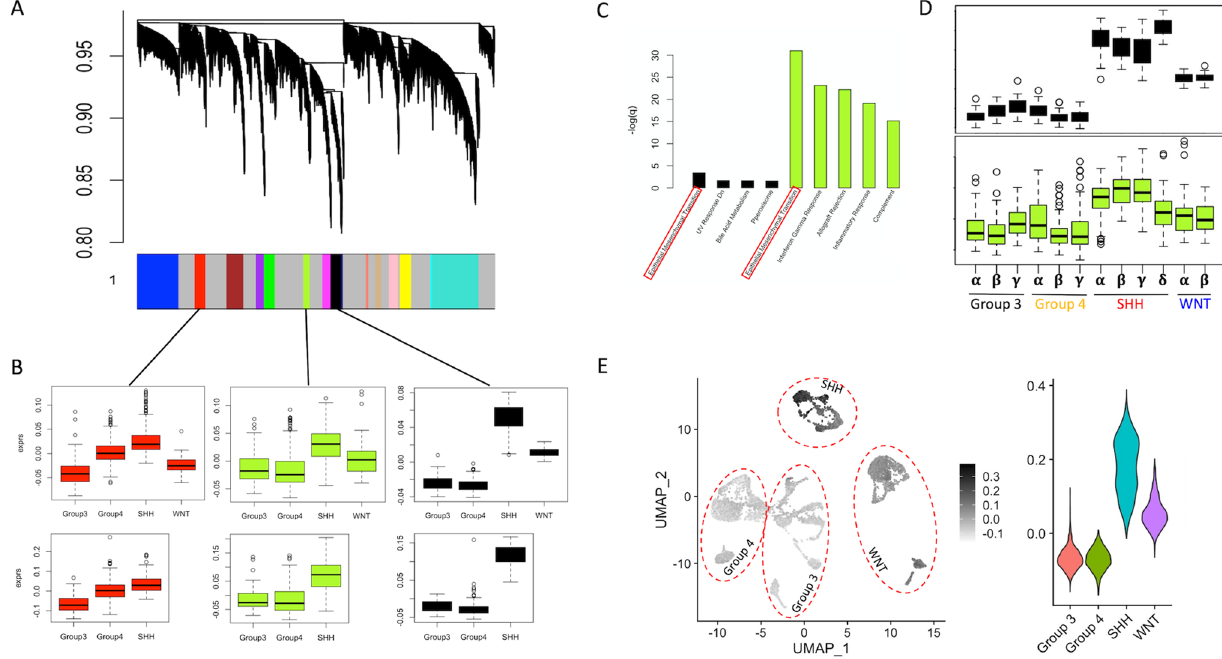
Figure 3. Weighted gene co-expression network analysis (WGCNA) yields SHH-specific TME signatures from the whole transcriptome. ( A ) Dendrogram depicting gene clustering and module selection, where module groupings are annotated by the color bar below. ( B ) Boxplots of the meta-gene expression for each module with highest expression in the SHH subgroup. Computed meta-gene expression of the same modules in the bulk validation cohort are present below. ( C ): Module annotation using MSigDB Hallmark genes. Only functions with adjusted p < 0.05 are included, and no more than 5 are included for each module. ( D ) Meta-gene expression of the black and greenyellow modules by molecular subtype in the discovery cohort. Note that the black module is strongly upregulated in all 4 SHH subtypes. E: UMAP plot of single-cell data, coloured by the meta-gene expression of the black module. The adjacent violin plot demonstrates significant upregulation in the SHH subgroup, which is consistent with bulk